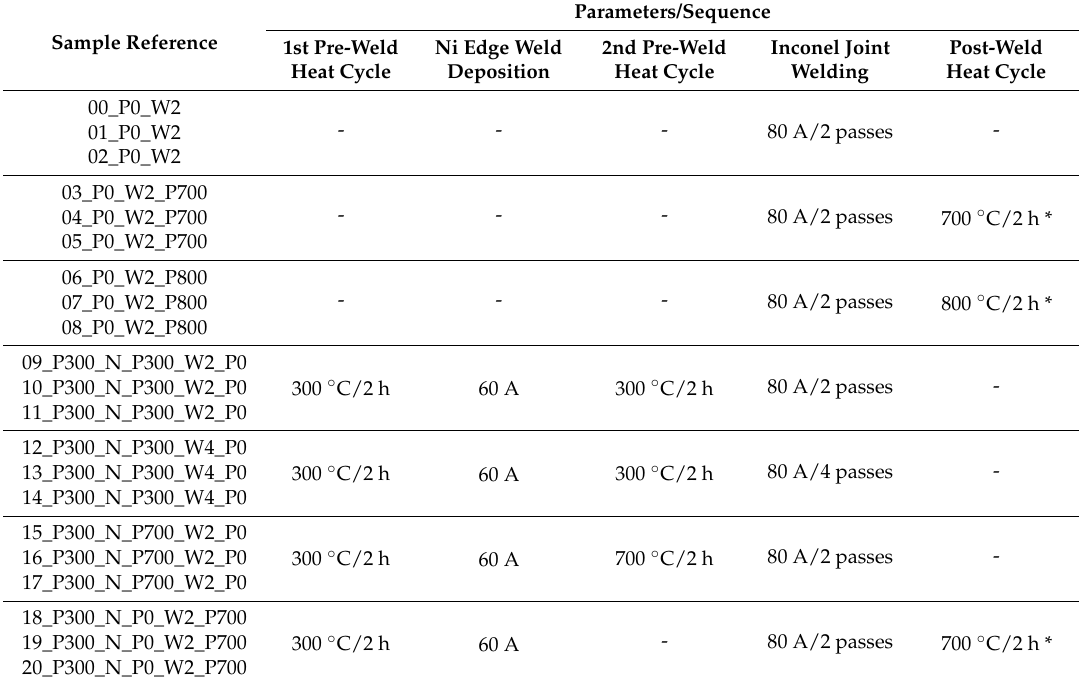
Table 2 demonstrates the different welding and heat treatment parameters adopted for each set of samples. Table 2. Welding and heat cycle parameters used to produce experimental